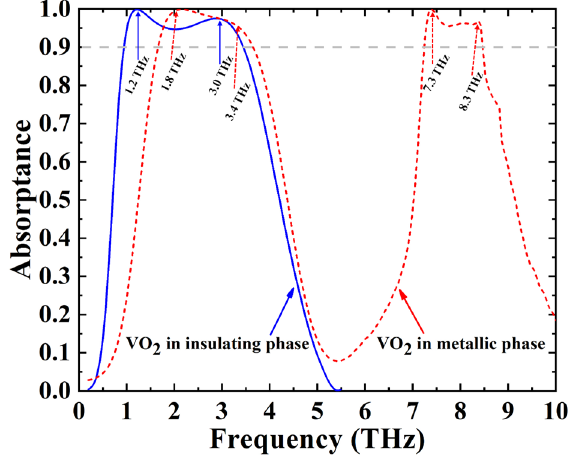
Figure 2. Absorptance spectrum of the absorber in two different modes.